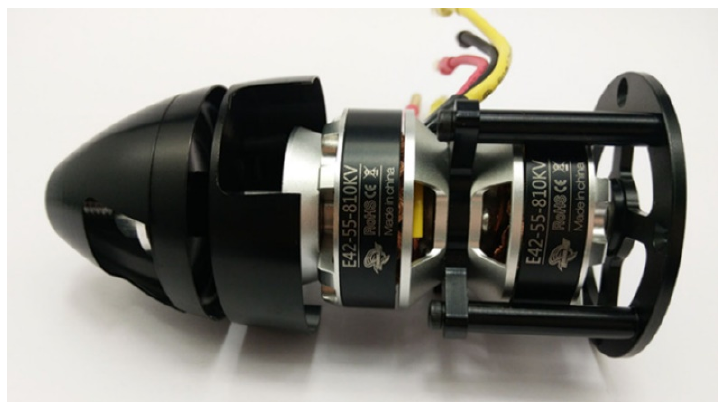
Figure 3. Coaxial motor.